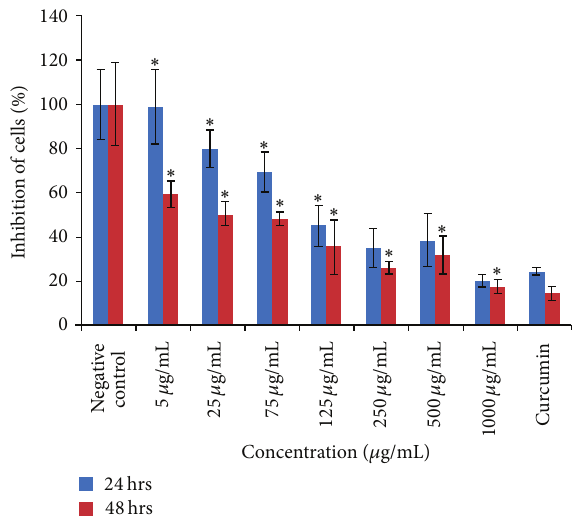
Figure 2: Effect of S. birrea acetone extract on proliferation of MCF- 7 cells at 24 and 72 h. Each value represented mean ± SEM of six replicates ( 𝑛 = 6 ); ∗ 𝑃 < 0.05 .